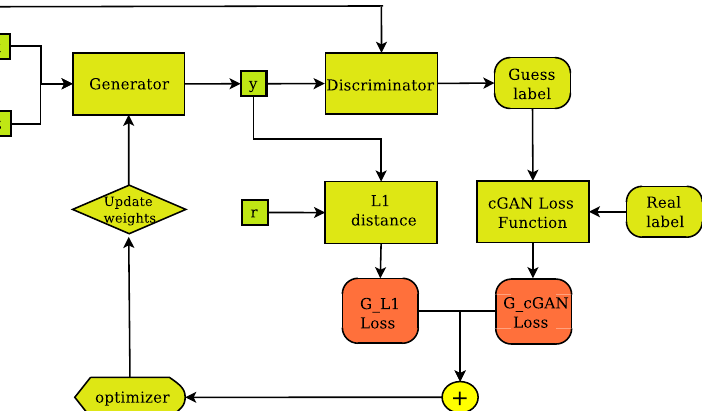
Figure 3. The pix2pix Generator’s training layout. The generator creates output image (y) from input image (x) and random noise vector (z) and improves its performance by receiving feedback from the discriminator, as well as regarding the degree of fakeness of the synthetic image (y) compared to the ground truth (r).